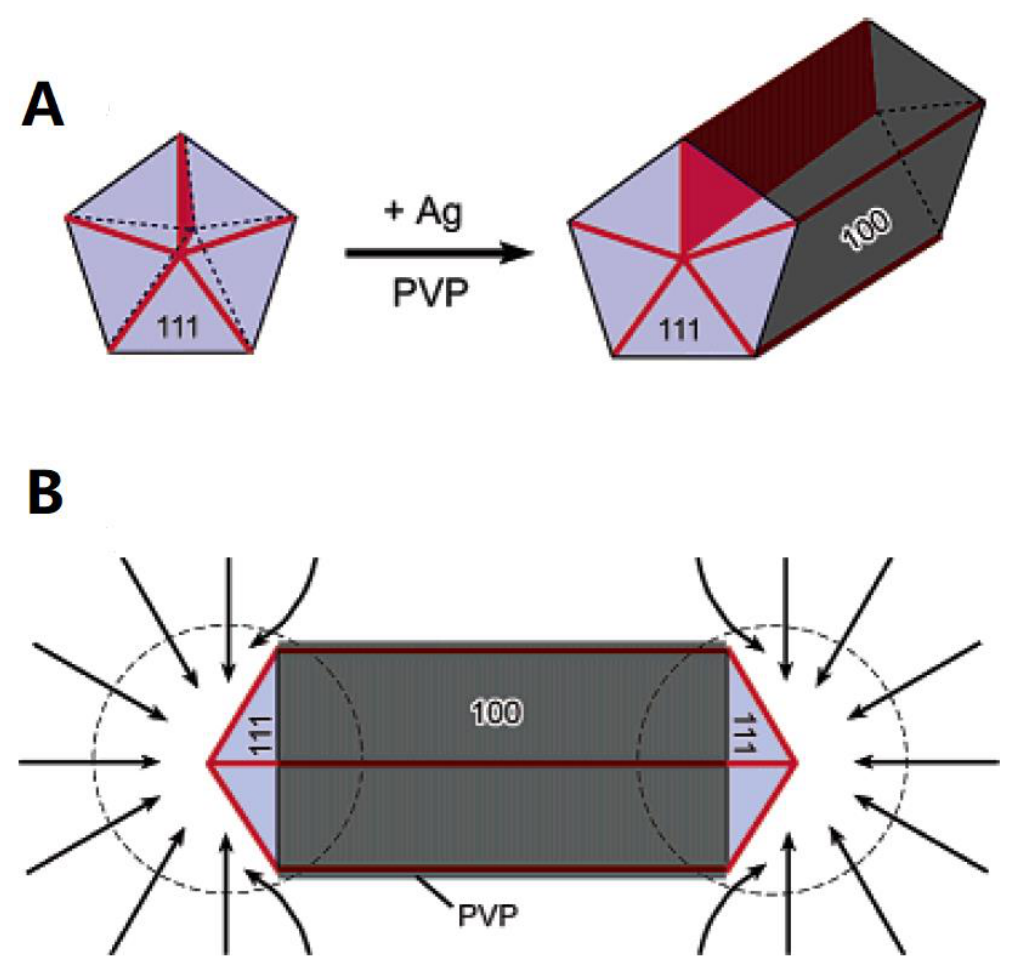
Figure 2. Growth mechanism of silver nanowires (AgNWs) from multiply twinned nanoparticles Figure2. Growthmechanismofsilvernanowires(AgNWs)withpentagonalcrosssections: ( A )evolution (MTPs) with pentagonal cross sections [38]. of a nanorod from a multiply twinned nanoparticles (MTPs) of silver and ( B ) di ff usion of silver atoms toward the two ends of a nanorod, with the side surfaces completely passivated by polyvinylpyrrolidone (PVP)